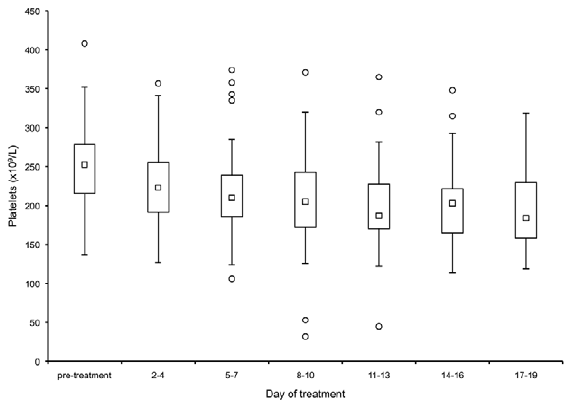
Figure 1. Box-and-whisker plot of the lymphocyte counts of patients plotted against duration of treatment with sodium stibogluconate (SbV). The group median (squares) fell significantly from its baseline by the first subsequent measurement, four days after initiating treatment ( p , 0.001). It then plateaued, with no further significant change. Outliers are depicted by circles, extremes are depicted by hashes.